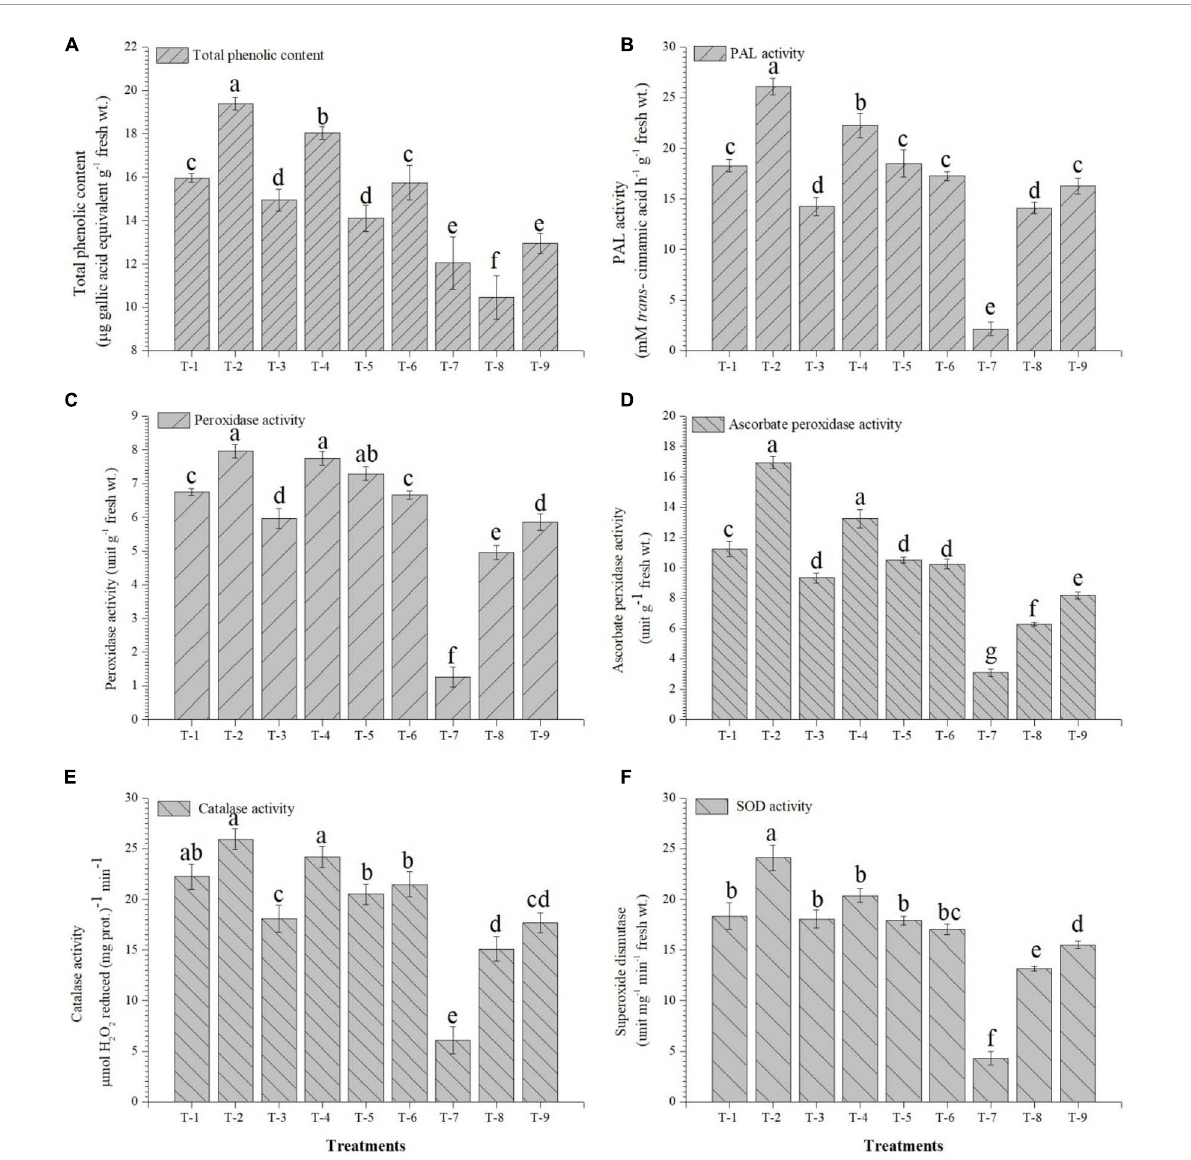
FIGURE7 Effects of seed treatment on activities and accumulation of antioxidant biomolecules and enzymes (A) total phenolic, (B) PAL, (C) peroxidase, (D) ascorbate peroxidase (E) catalase, and (F) superoxide dismutase in the pigeonpea leaves at 30 days of sowing treatments were: T 1 - Stenotrophomonas maltophilia DRC-18-7A + Sulfate compound, T 2 - S. maltophilia DRC-18-7A + Elemental S, T 3 - S. pavanii DRC-18-7B + Sulfate compound, T 4 - S. pavanii DRC-18-7B + Elemental S, T 5 - S. maltophilia DRC-18-7A, T 6 - S. pavanii DRC-18-7B, T 7 -Sulfate compound, T 8 -Elemental S and T 9 -untreated control (-S). Data are mean ( n = 10) and vertical bar represents standard deviation. Data with different letters show significant difference in column data in randomized block design test at p < 0.05 under Duncan’s multiple range